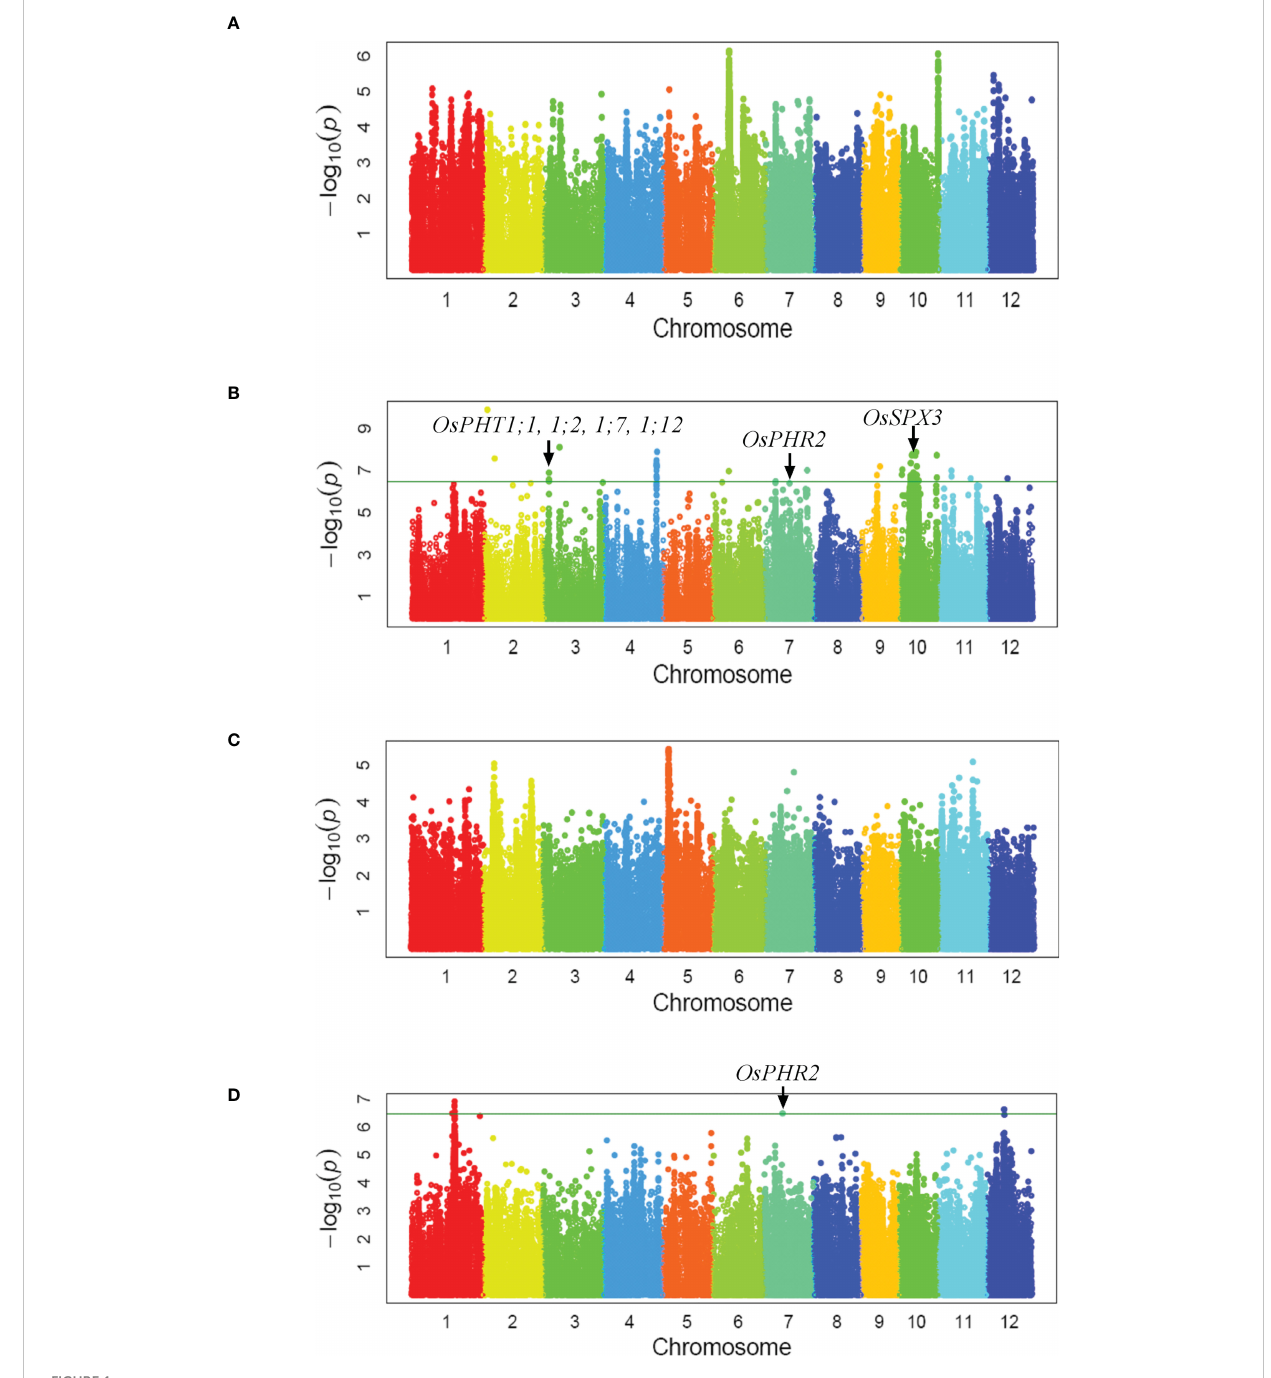
FIGURE 1 Genome-wide association study. Manhattan plots of GWAS mapping for two-year averages of biomass per plant (A, B) and grain yield per plant (C, D) measured under normal (A, C) and low Pi-fertilizer supply (B, D) ,